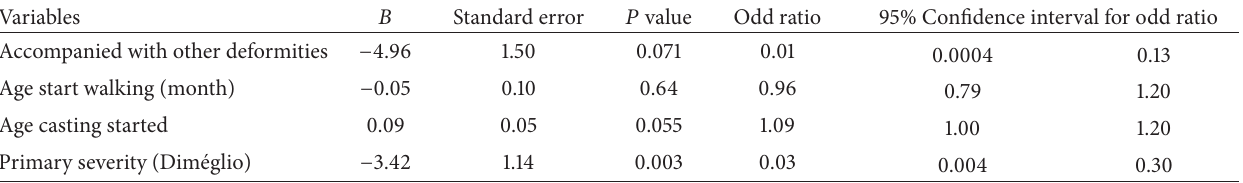
Table 4: Multivariable analysis: factors may be associated with further